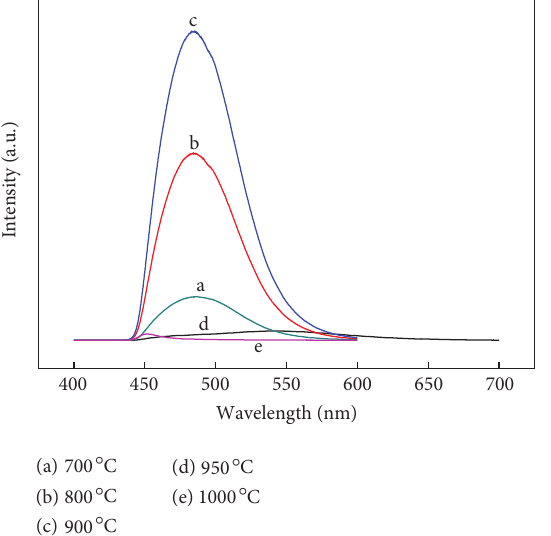
F 5: Emission spectra of samples obtained at different reduc- tive temperature.